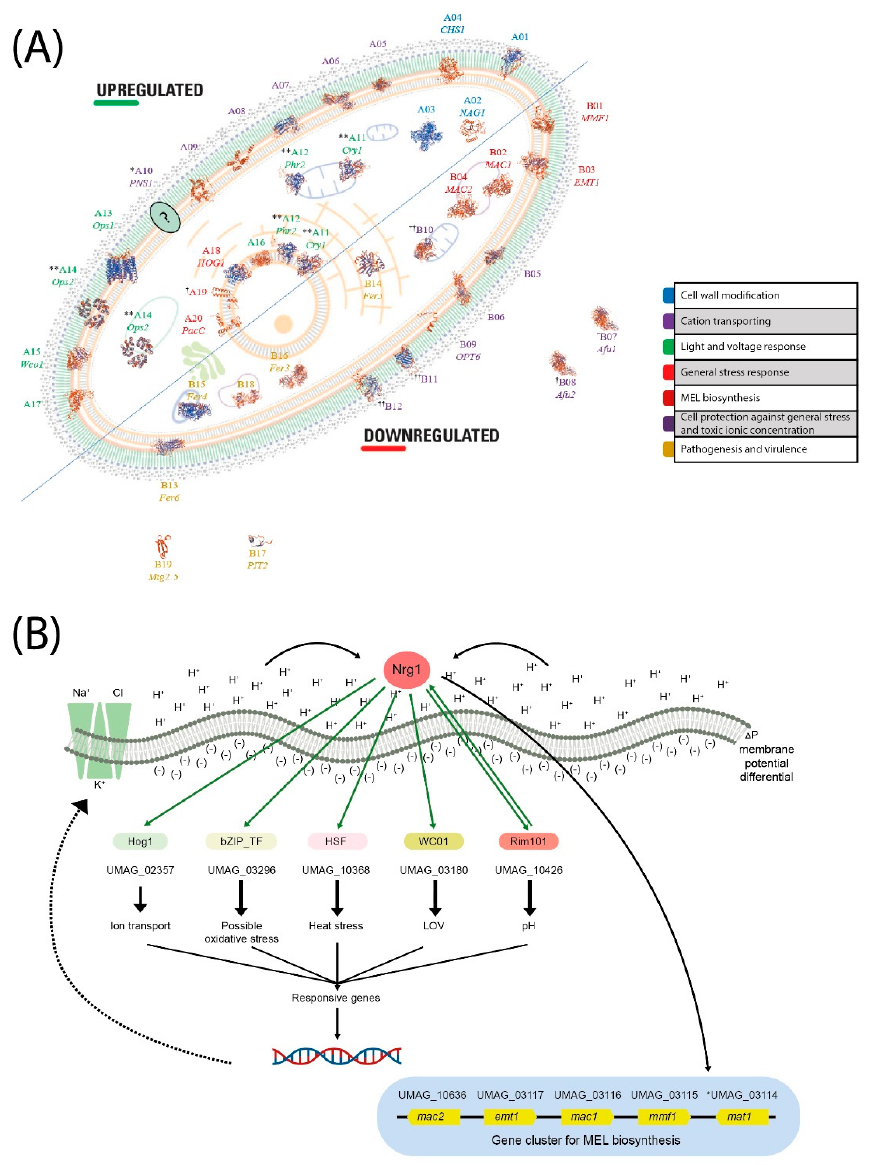
Figure 9. Analytical interpretation of the enrichment of transcriptomic analysis of NRG1 at acid pH in the Basidiomycota U. maydis . ( A ) Subcellular localization of regulated proteins by Nrg1 . The localization of proteins is shown based on gene ontology, sequence similarity and curator. The protein structure was modeled in ExPASy tool swiss model platform available in www.swissmodel.expasy.org/interative. ( B ) Nrg1 function; in an acidic pH environment, the tran- scription factor Nrg1 regulates the expression of another pH regulator RIM101 , the photoreceptor WCO1 , a bZIP transcription factor, a putative mitogen-activated protein kinase HOG1 , a gene cluster for MEL biosynthesis and others. Growth in the acidic pH environment of U. maydis , cells activate a concerted response, while the external cation-rich zone (pH 4) forms a membrane potential difference; these conditions induce the exchange of K + , Na + and Cl − ions and a transcriptomic